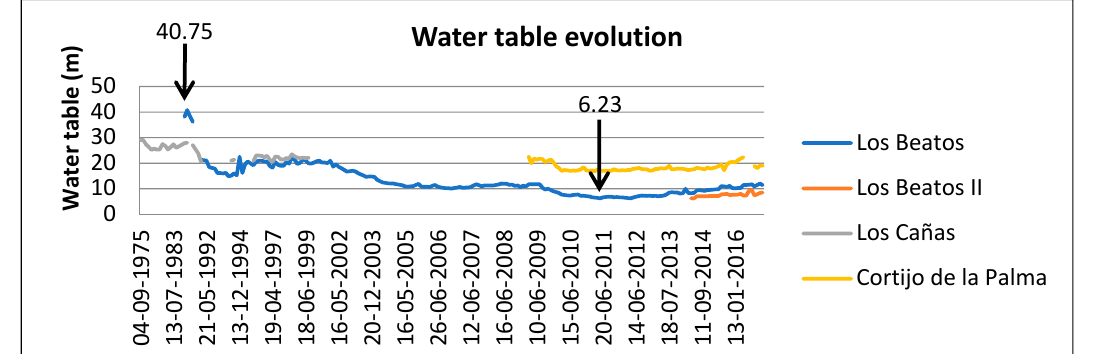
Figure 9. Water table evolution in Miranda.